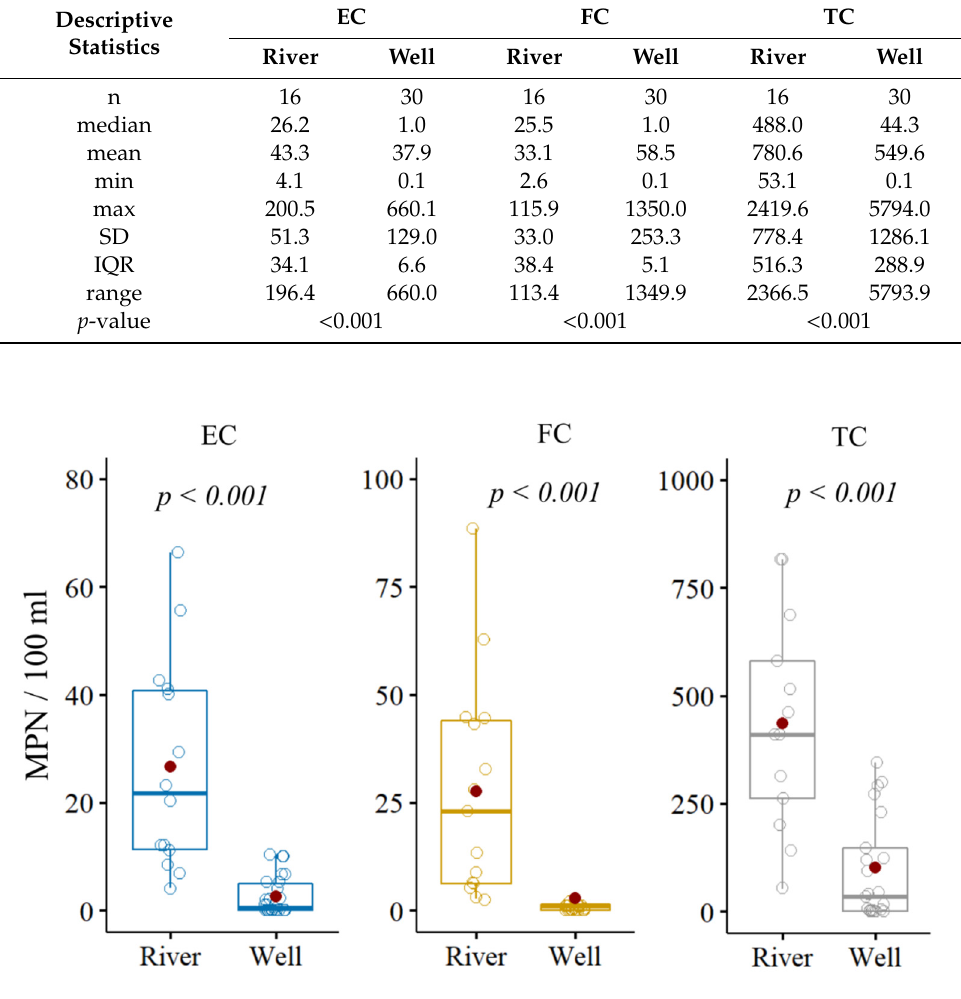
Figure 3. Box plots of coliform concentrations for E. coli (EC), fecal coliforms (FC), and total coliforms (TC). Plots distinguish between river and well samples. Note that outliers were not shown to ensure a better comparison between both groups. Red dots mark the mean value of each population. The given p -values are the results of the Wilcoxon signed-rank test to test for significant differences in the mean rank of coliform concentrations between the river and wells. p -values smaller than 0.05 indicate a significant difference.